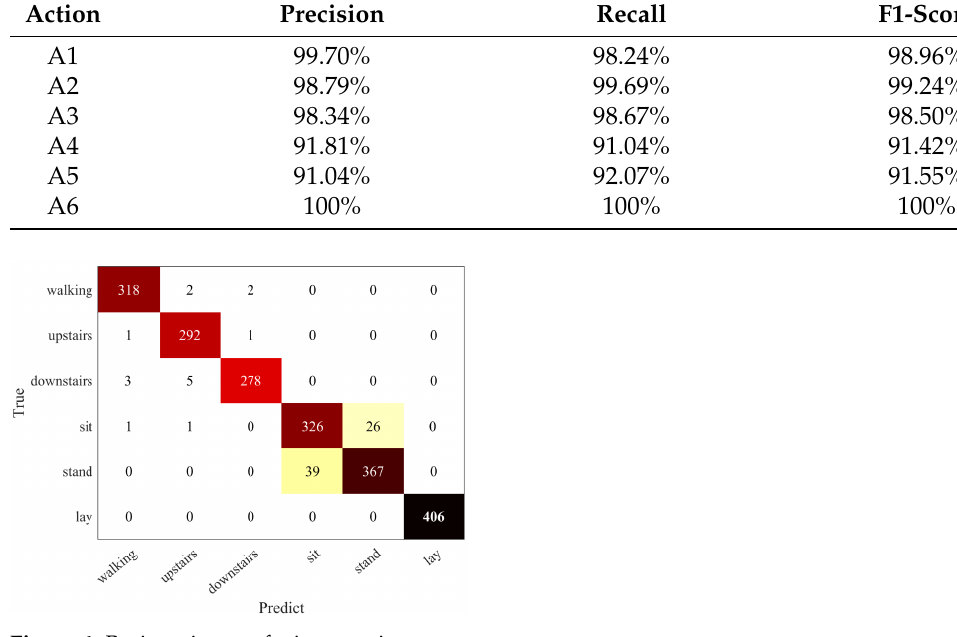
Figure 4. Basic action confusion